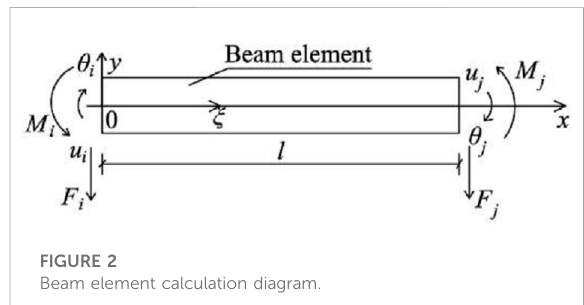
FIGURE 2 Beam element calculation